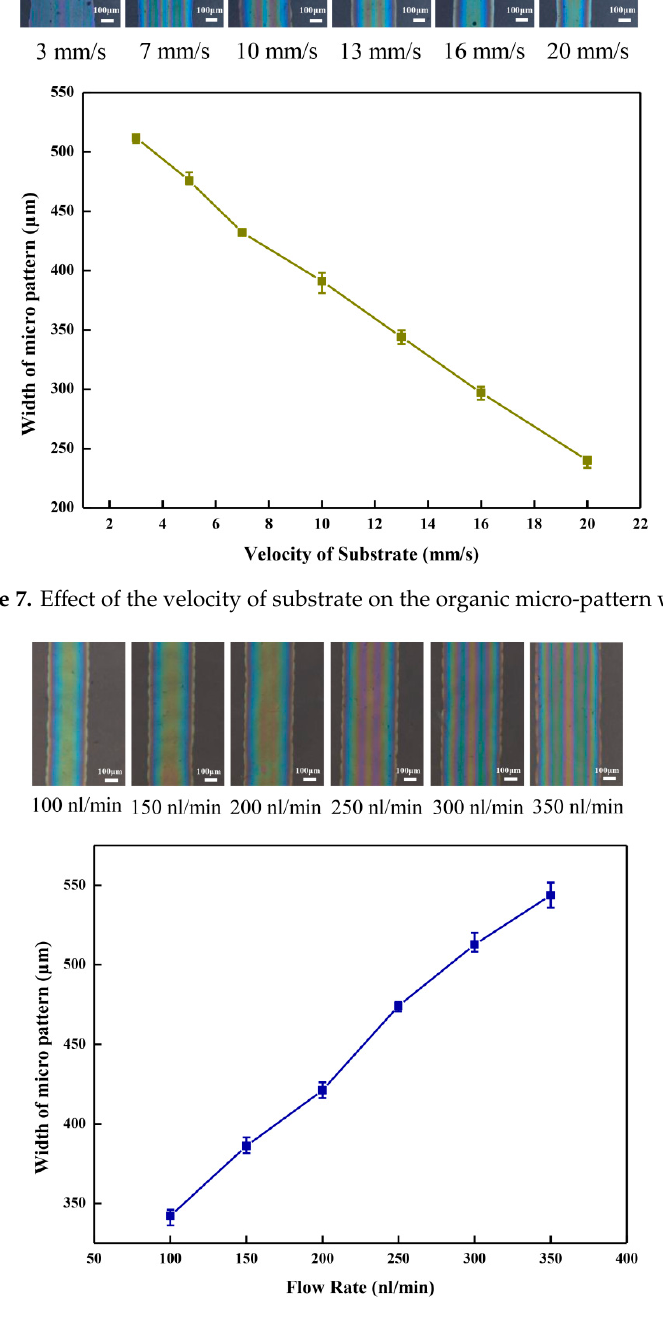
Figure 8. E ff ect of the flow rate of the injection system on the organic micro pattern Figure 8. Effect of the flow rate of the injection system on the organic micro pattern width.